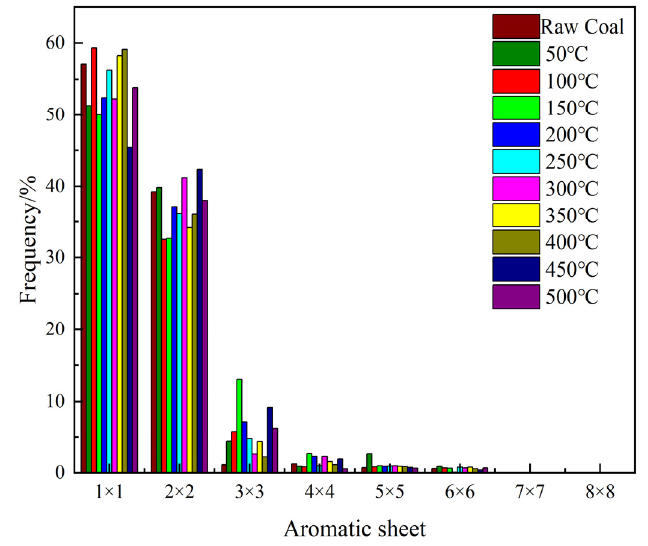
Figure 13. Distribution of aromatic fringes in coal samples.